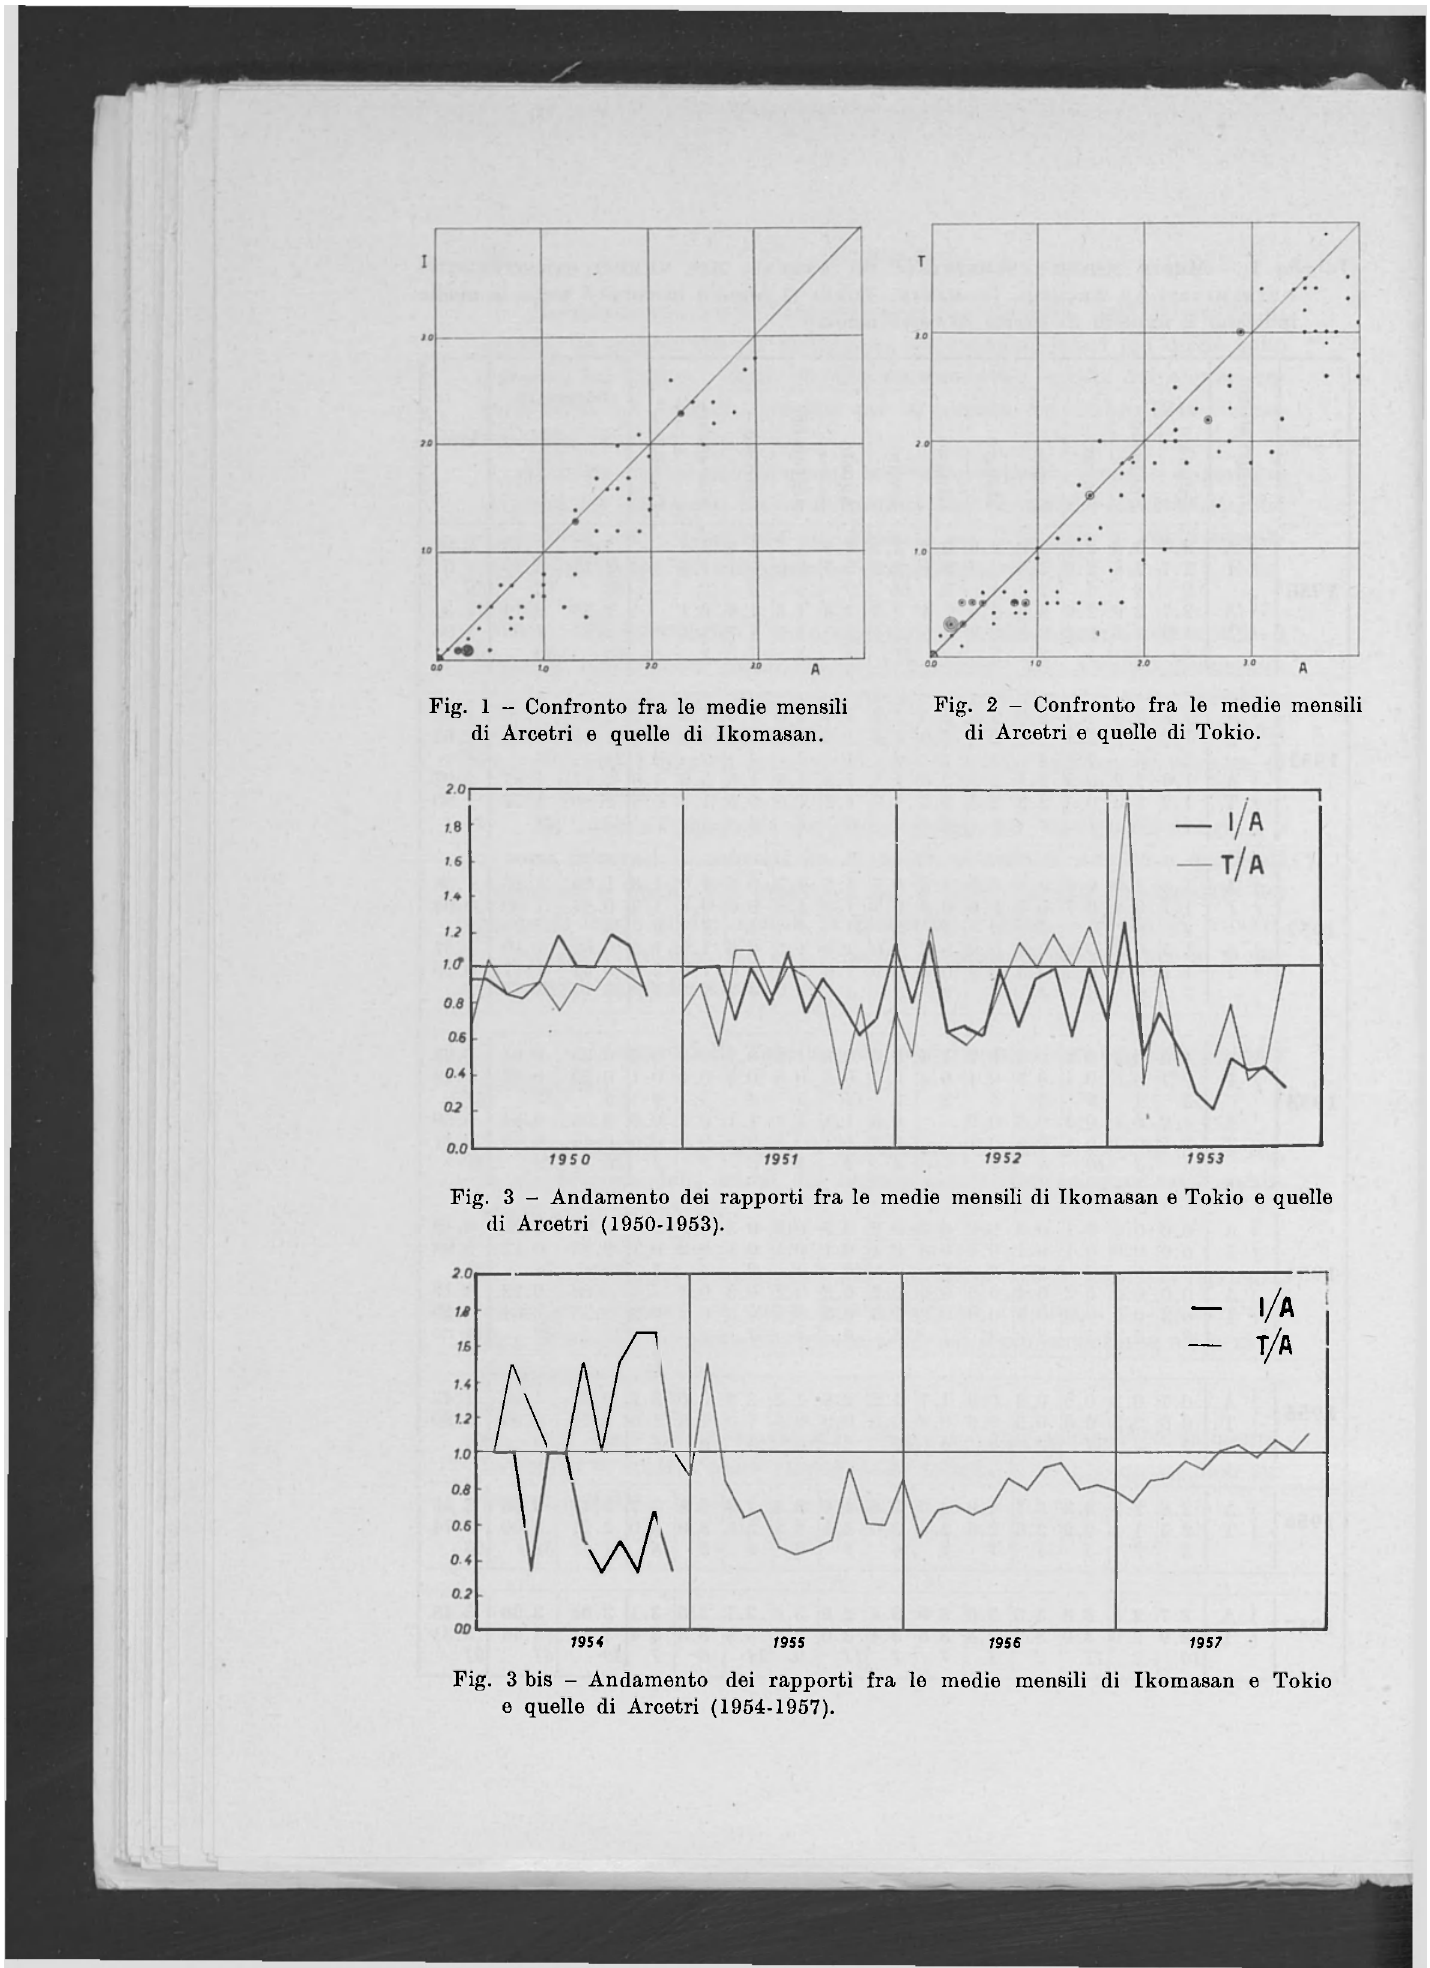
Fig. 3 bis - Andamento dei rapporti fra le medie mensili di Ikomasan e Tokio e quelle di Arcetri